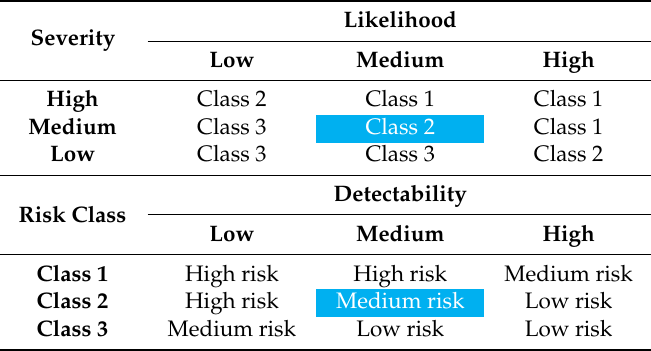
Table 3. PERV Risk Assessment based on the current scientific knowledge and clinical experience 1